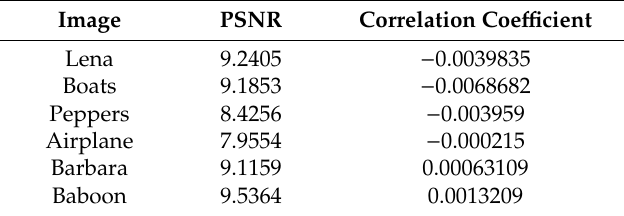
Table 1. Correlation coefficient, PSNR values between original and encrypted images using proposed